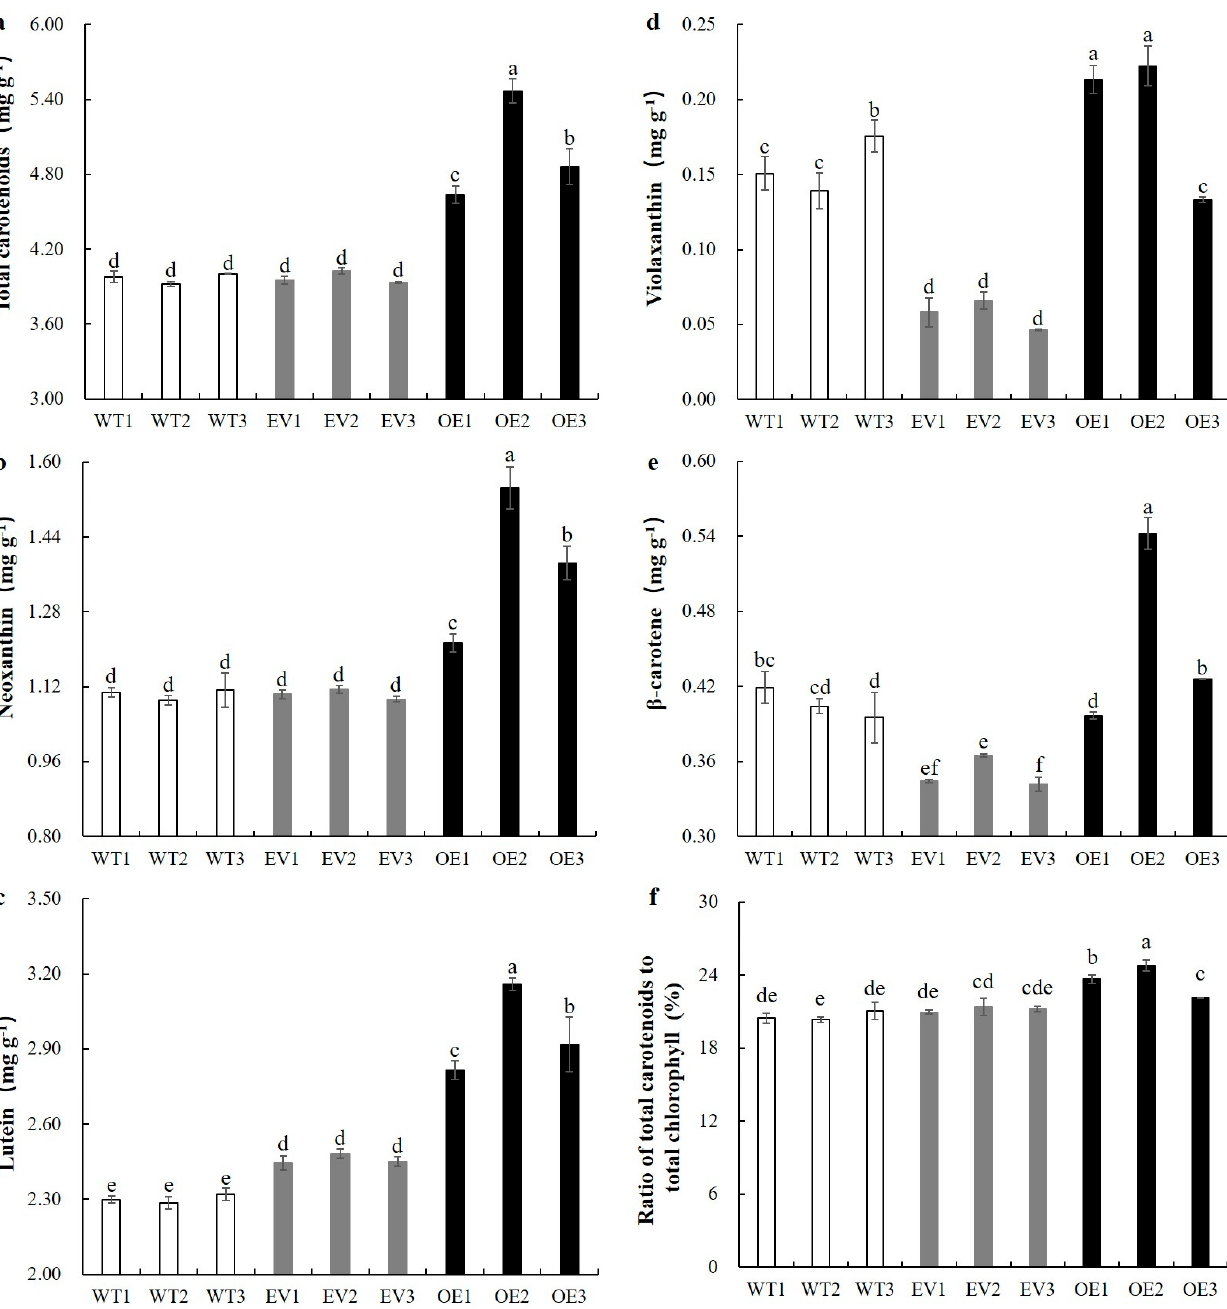
Figure 5. Individual and total carotenoid content and ratio of total carotenoids to total chlorophyll of wild-type (WT), the agroinfiltrated plants with empty vector (EV), and the BoaNXS -overexpressed plants (OE) in Chinese kale. ( a ) content of total carotenoids; ( b ) neoxanthin content; ( c ) lutein content; ( d ) violaxanthin content; ( e ) β -carotene content; ( f ) ratio of total carotenoids to total chlorophyll. Samples of leaves were taken from the control (WT), EV, and OE plants at the second day after the last injection. Data are expressed as mean ± standard deviation. Different letters above the bars indicate significantly different values ( p < 0.05) according to a Least Significant Difference (LSD) test.